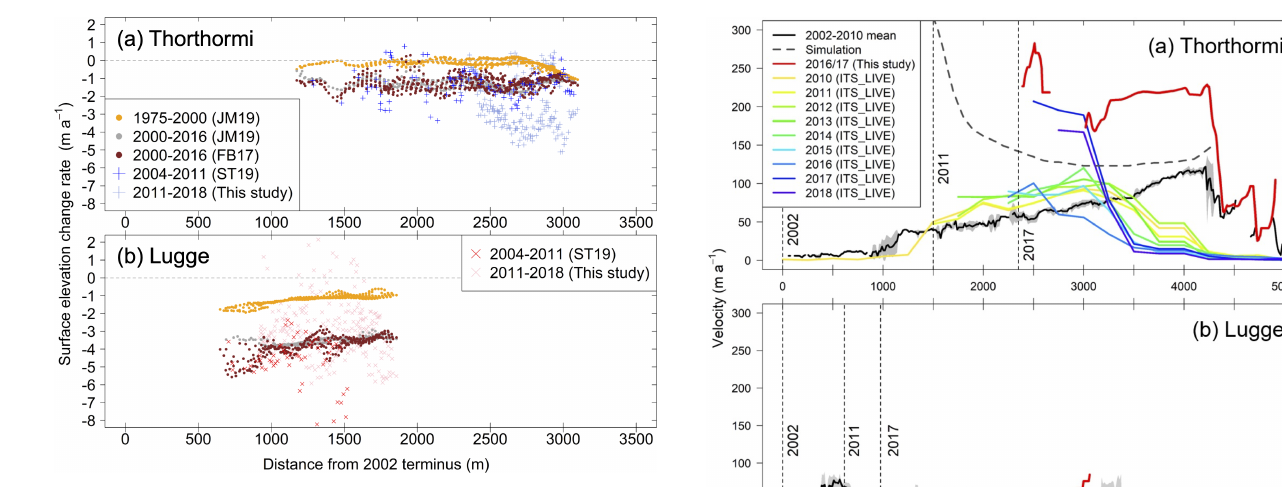
Figure 3. Surface elevation change rates (d h/ d t ) along (a) Thorthormi and (b) Lugge glaciers (based on the distance from the 2002 glacier terminus). Each panel shows the elevation change rates for 1975–2000 and 2000–2016 (Maurer et al., 2019; JM19), 2000–2016 (Brun et al., 2017; FB17), 2004–2011 (Tsutaki et al., 2019; ST19), and 2011–2018 (this study). HP-DEM and GPS-DEM are resampled to a 30m resolution for comparison with the d h/ d t datasets from previous studies.